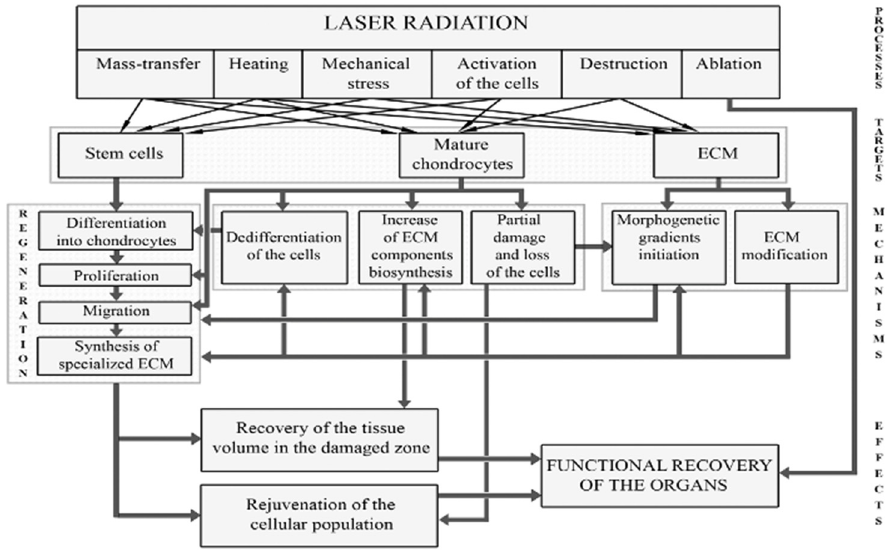
Figure 2. Targets for laser radiation and regeneration processes leading to the restoration of IVD. Laser radiation can directly affect (a) cells; (b) various components of the ECM; (c)